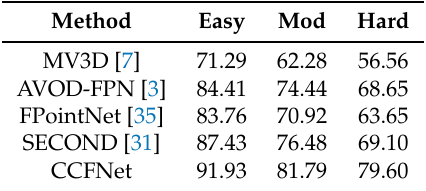
Table 4. Performance comparison with the compared methods on 3D car detection (AP, %) on the KITTI validation set.